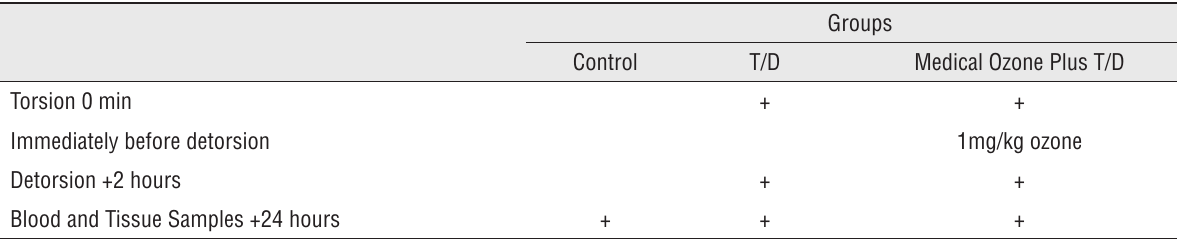
Table 1 - A summary of the procedures in the experimental groups.